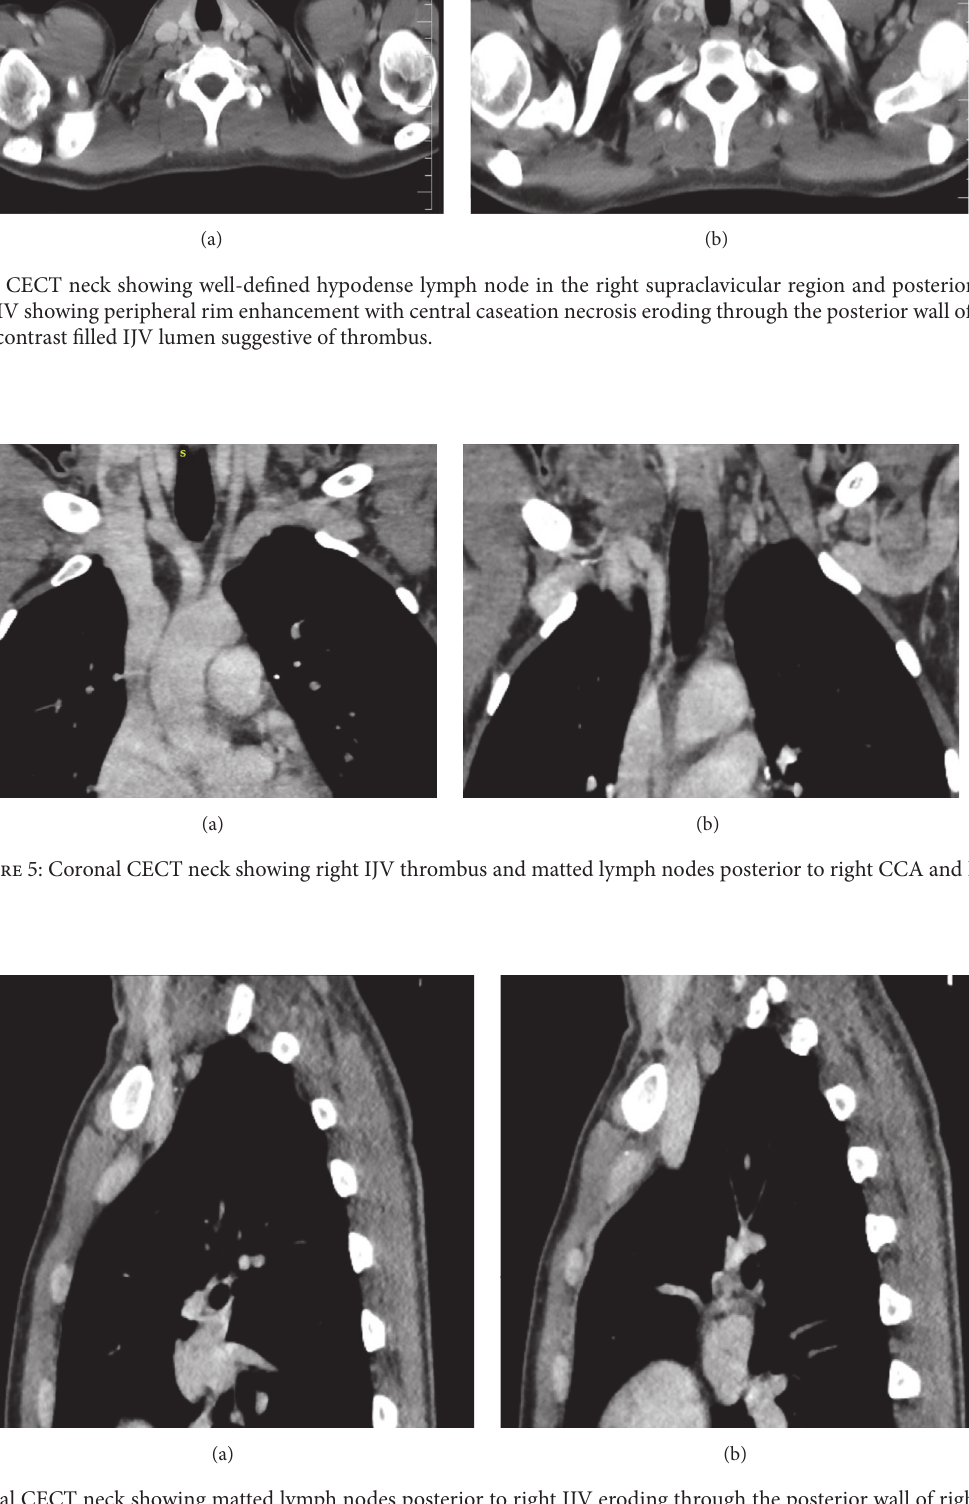
Figure 6: Sagittal CECT neck showing matted lymph nodes posterior to right IJV eroding through the posterior wall of right IJV with IJV